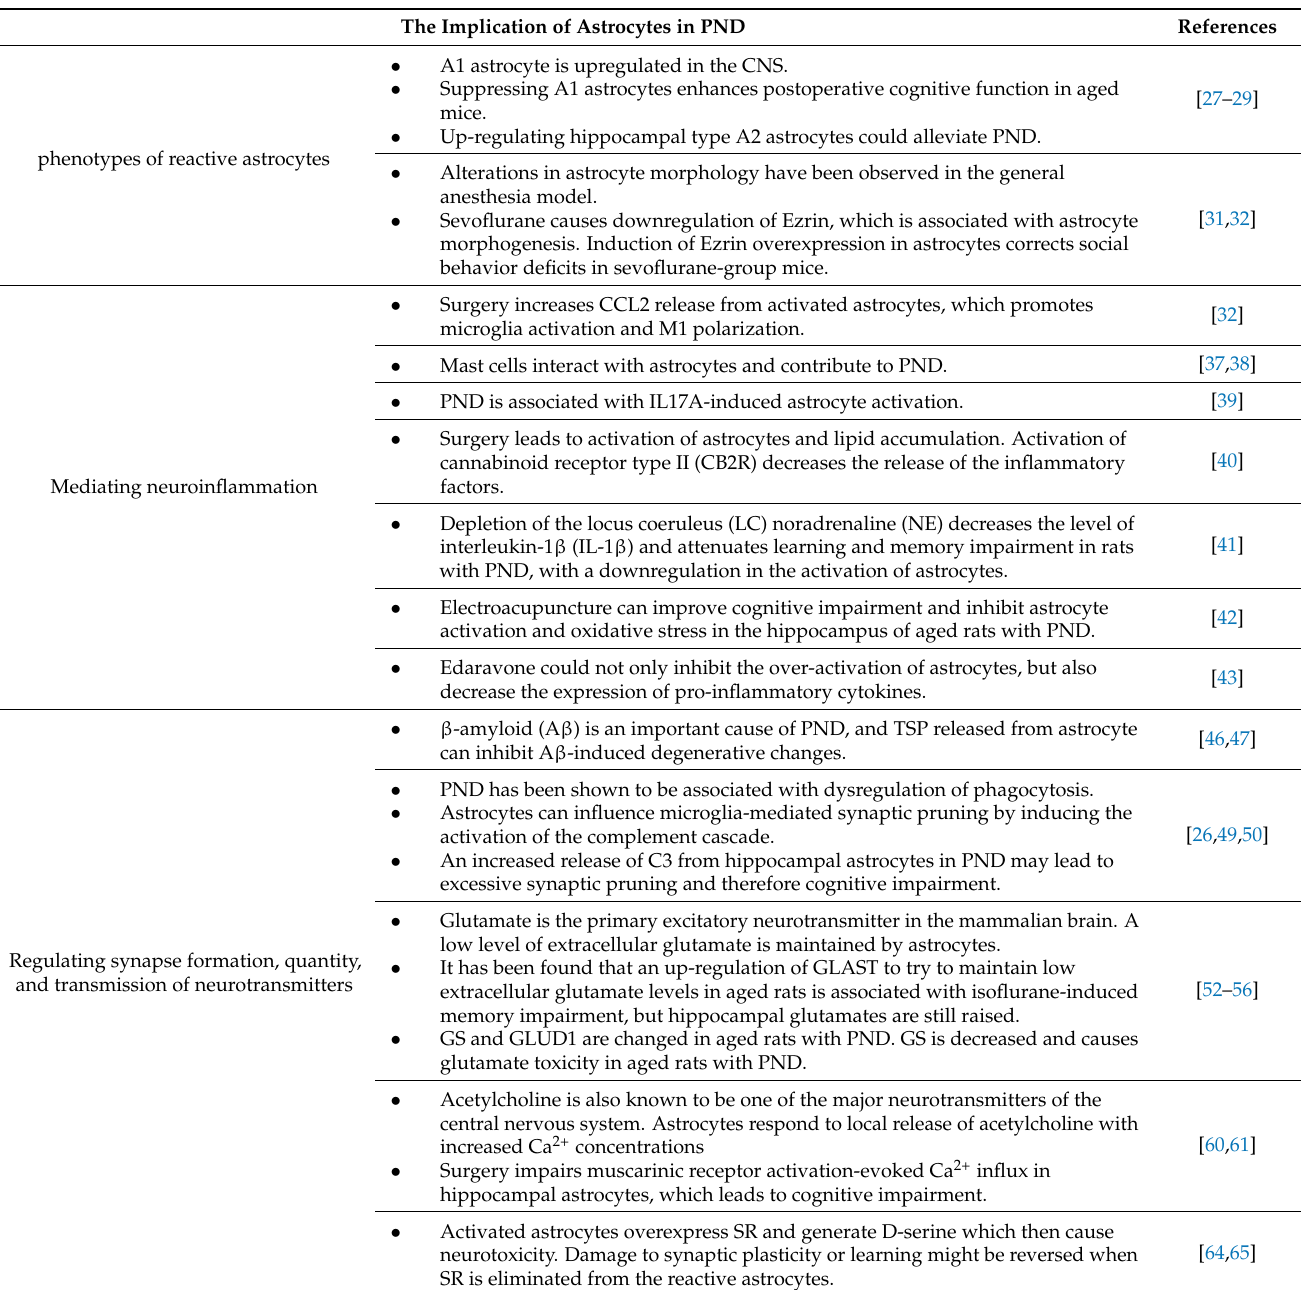
Table 1. The implication of astrocytes in PND. C3: Component C3. CCL2: chemokine C-C motif ligand 2. TSP: thrombospondin. GLAST: glutamate transporters. GS: Glutamine synthetase. GLUD1: glutamate dehydrogenase 1. SR: serine racemase. BBB: blood–brain barrier. AQP-4: aquaporin4. GDNF: glial cell line-derived neurotrophic factor. Shh: Sonic hedgehog. VEGF: vascular endothelial growth factor. ApoE: apolipoprotein